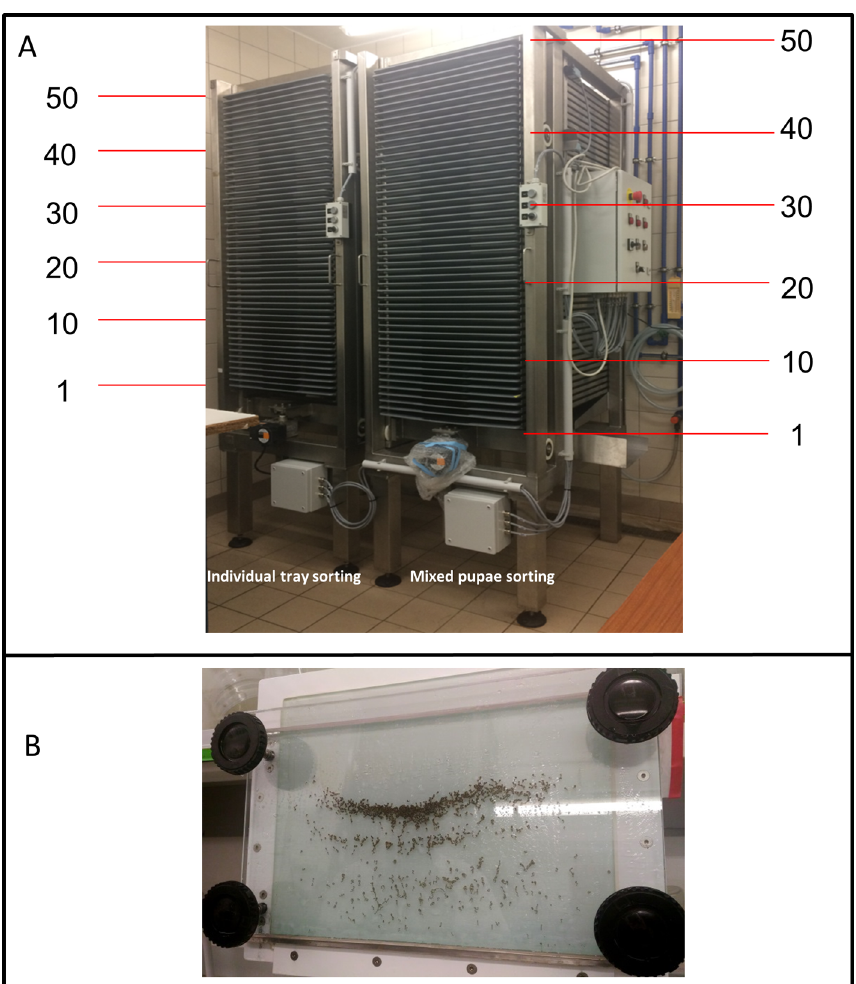
Figure 1. (A) The FAO/IAEA larval rearing unit with the experimental selected larval trays positions and (B) the Fay – Morlan glass plate